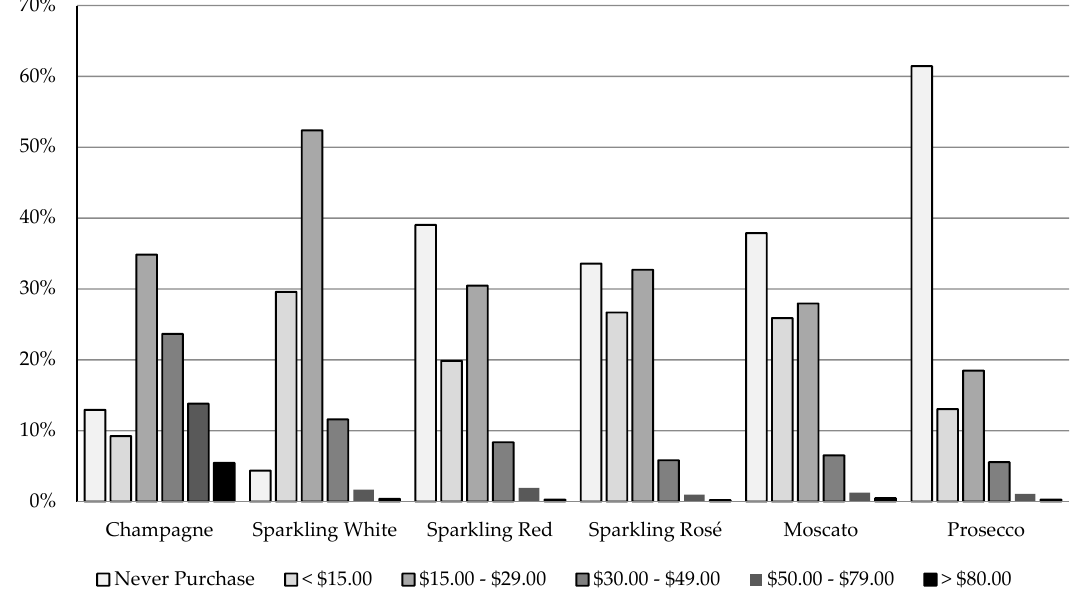
Figure 1. Consumer spending per bottle (AUD) on different sparkling wine styles.